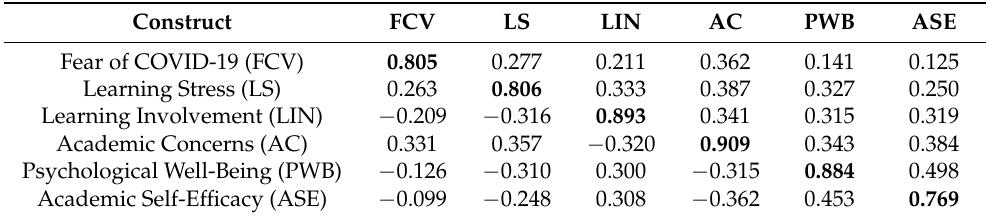
Table 3. Discriminant